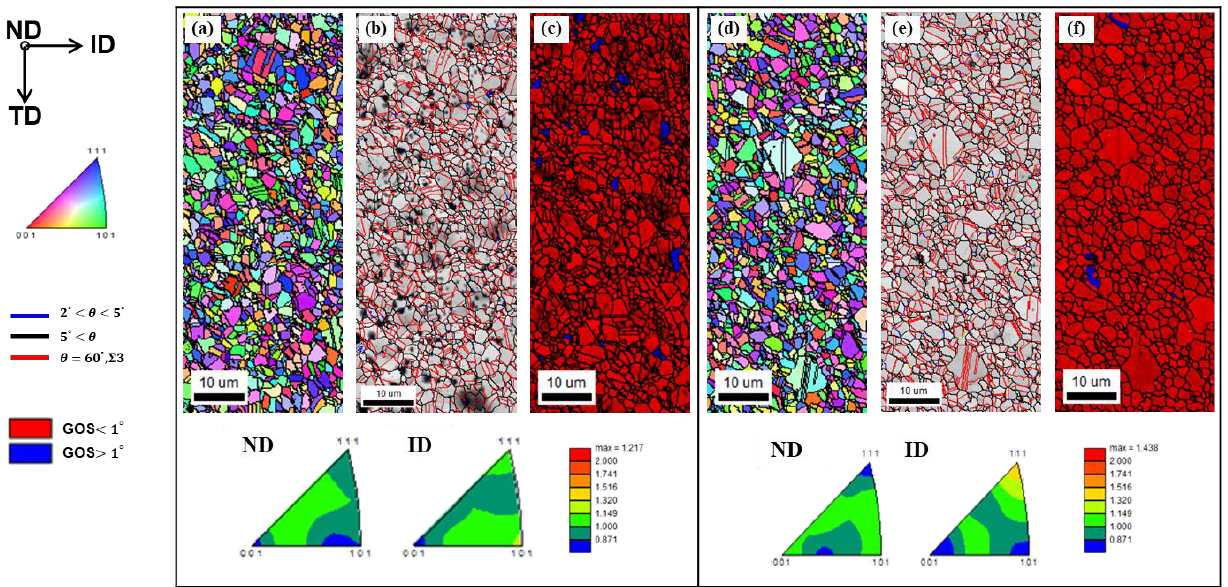
Figure 3. Inverse pole figure (ID), grain boundary (overlaid on the image quality), and GOS maps of ( a – c ) FGM Cu and ( d – f ) FGH Cu before the DTE tests. The horizontal direction is the powder injection direction